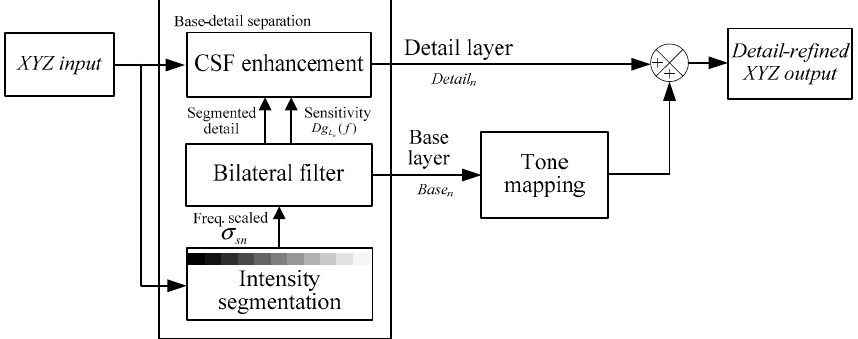
Figure 5. Flowchart of proposed segmented base–detail separation.